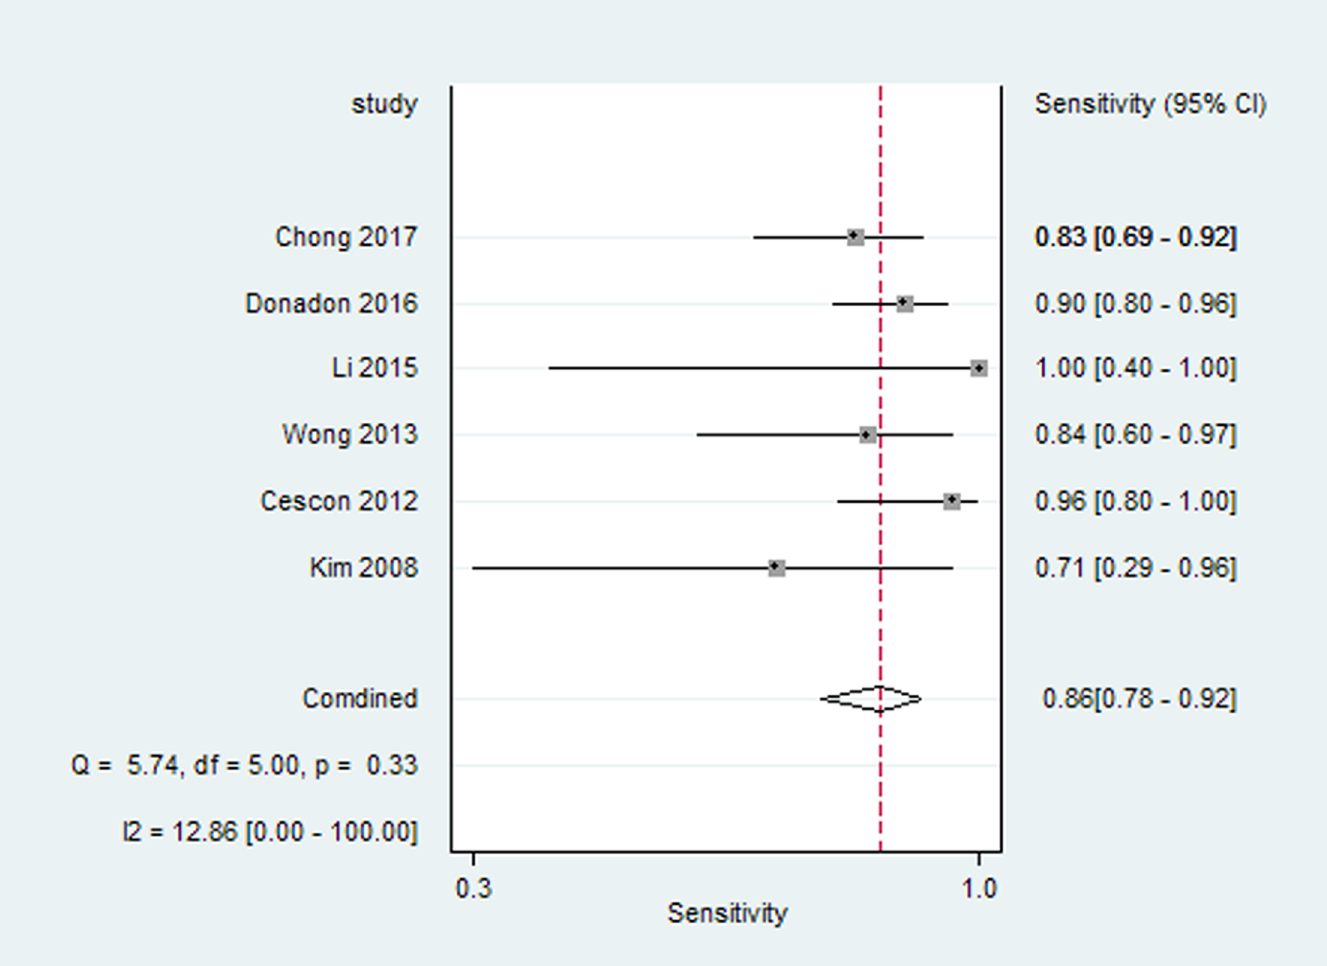
Fig 3. Forest plot meta-analyses of studies evaluating the sensitivity of live stiffness measured by TE to predict the overall postoperative complications.